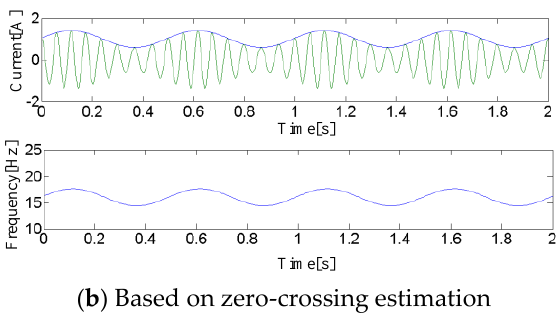
( b ) Based on zero-crossing estimation Figure 8. Simulation test result of time-frequency spectrum.